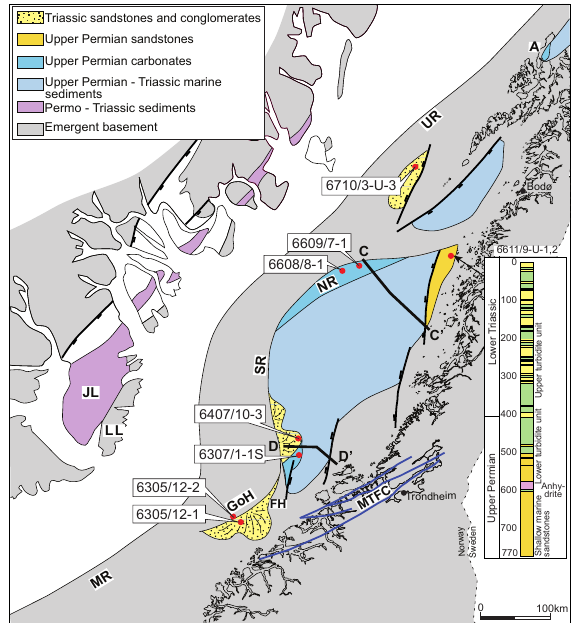
geography. Wells that have encountered Upper Permian–Lower Triassic syn-rift sediments are shown. The deep basin area was bordered by basement highs.